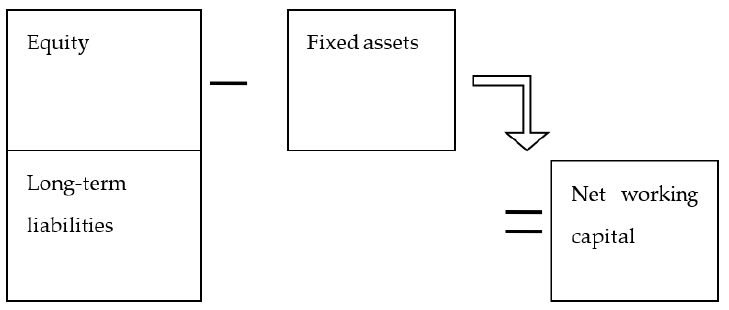
Figure 2. Net working capital on a capital basis. Source: own research.